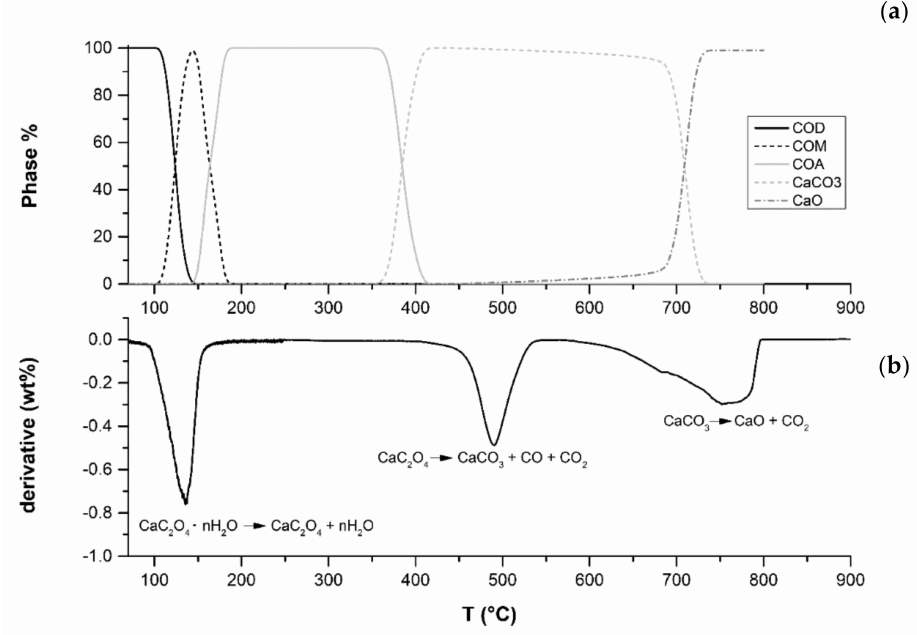
Figure 6. XRPD ( a ) data related to the appearance/disappearance of crystal phases from the decom- position of weddellite compared with the DTG ( b ) calculated from TG